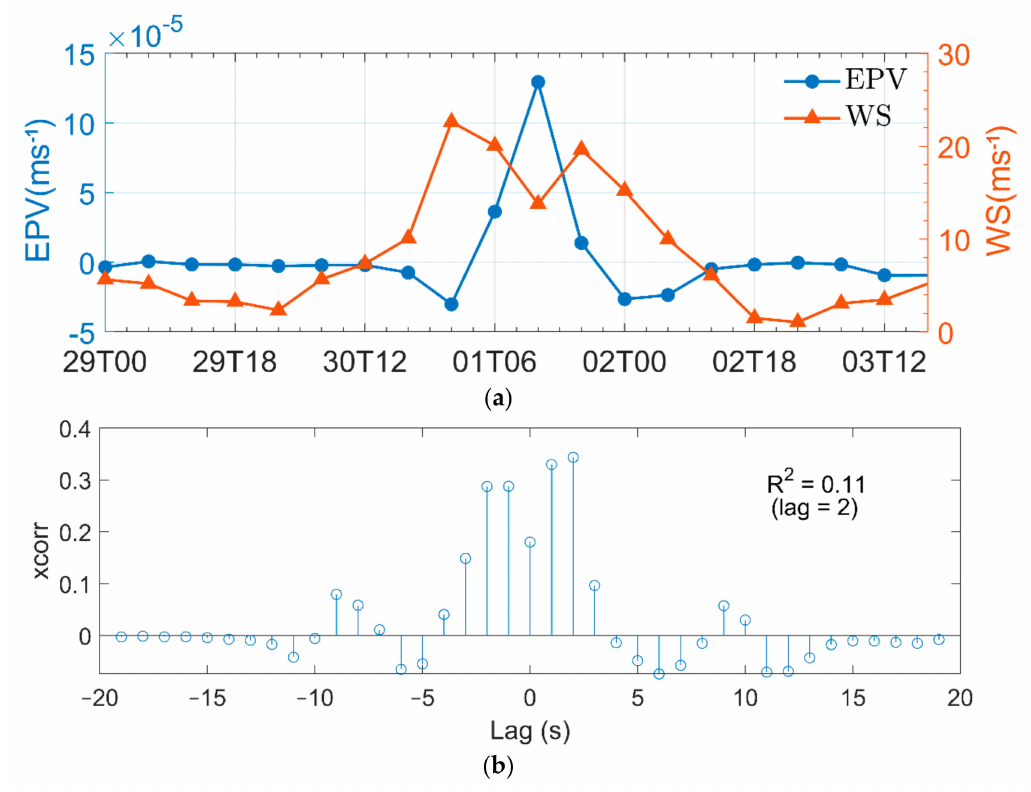
Figure 8. ( a ) The variation in Ekman pumping velocity (EPV) and wind speed (WS) at Zhoushan sea area. ( b ) The cross-correlation analysis diagram of EPV and